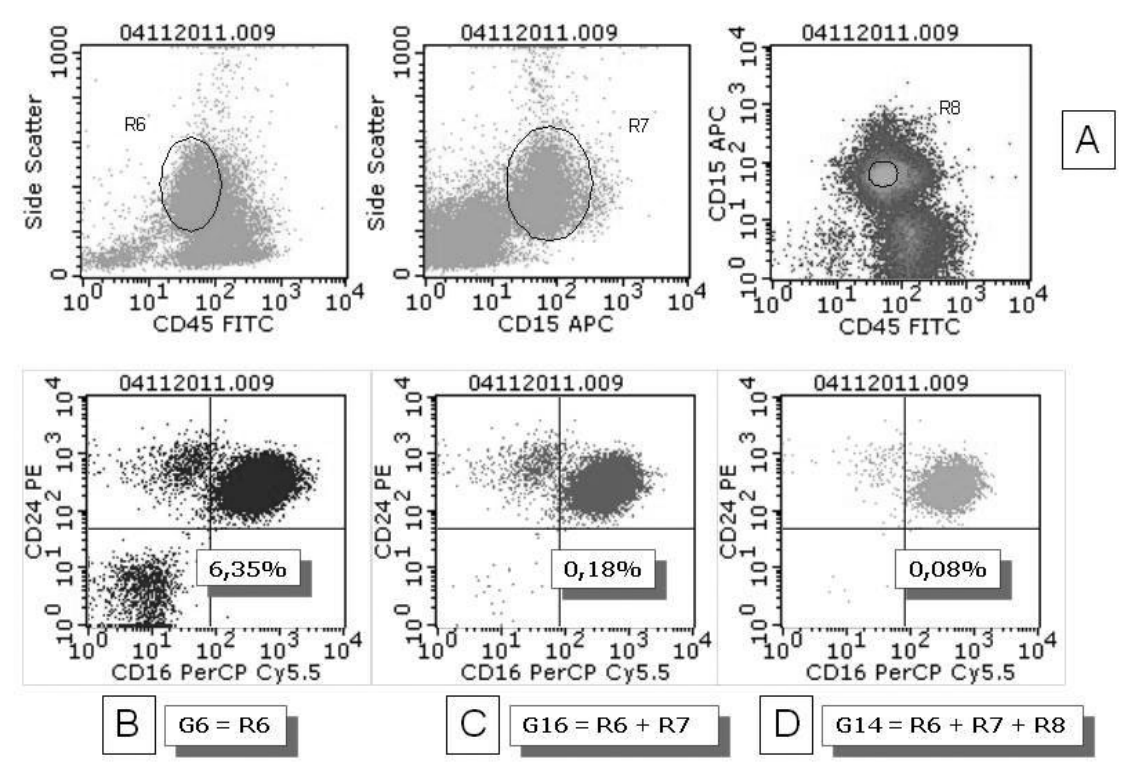
figurE 3 – Impact of multiparameter analysis strategy on the selection of neutrophils, in a sample from a MDS patient A) definition of gates for the selection of the neutrophil population to be analyzed, considering the expression of CD45 × SSC (R6) and CD15 × SSC (R7) in fluorescence dot plots, and the expression of CD45 × CD15, in density graphs (R8); B) analysis of the expression of CD16 and CD24 markers in neutrophils selected just by parameters SSC × expression of CD45 (G6 = R6); C) analysis of the expression of CD16 and CD24 markers in neutrophils selected by the combination of regions R6 + R7 (G16); D) analysis of the expression of CD16 and CD24 markers in neutrophils selected by the combination of regions R6 + R7 + R8